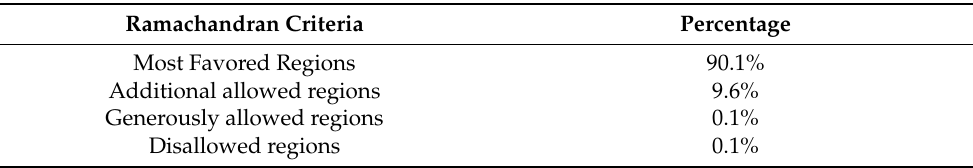
Table 5. The results of the validation of the quality of the 3WBP structure using a PROCHECK program that relies on the Ramachandran